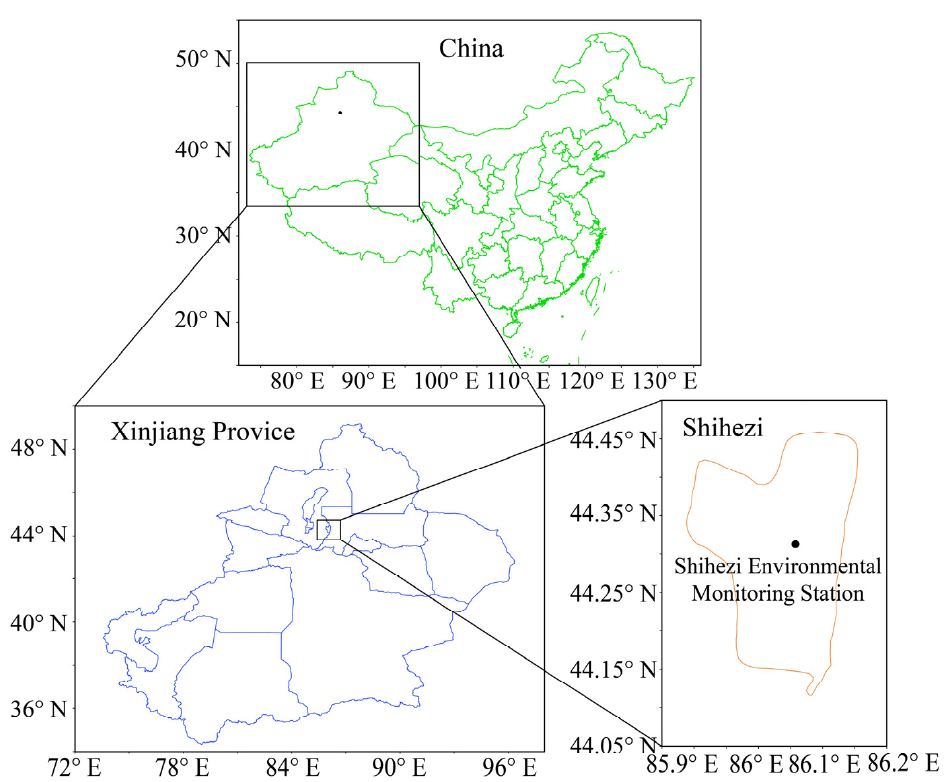
Figure 1. Location of the sampling site in Shihezi City, Xinjiang, China.